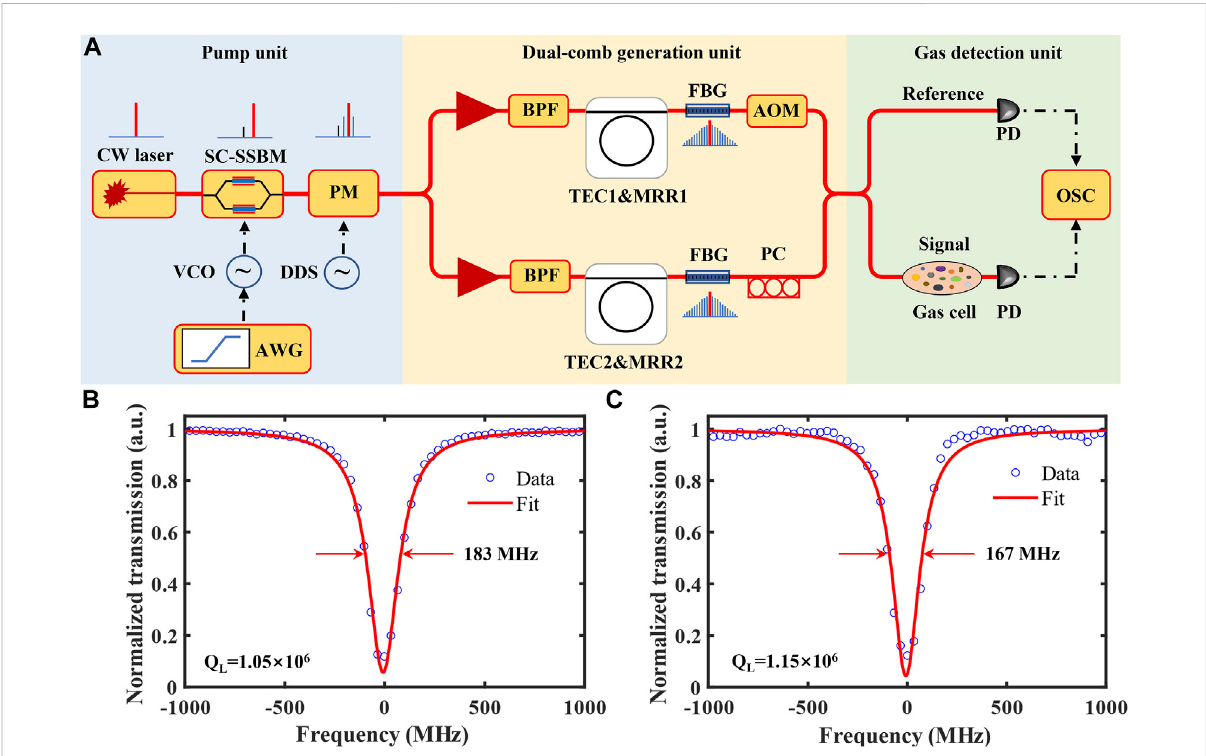
FIGURE 1 Experimental setup for dual-microcomb generation for spectroscopy. (A) Schematic of the experimental setup. SC-SSBM, suppressed-carrier single-sideband modulator; VCO, voltage-controlled oscillator; AWG, arbitrary waveform generator; PM, phase modulator; DDS, direct digital synthesis; BPF, band-pass fi lter; TEC, thermo-electric cooler; MRR, microring resonator; FBG, fi ber Bragg grating; AOM, acousto-optic modulator; PC, polarization controller; PD, photodetector; OSC, oscilloscope; (B,C) are transmission spectra and Lorentzian fi ts for Q-factors measurements of two MRRs ’ soliton modes,